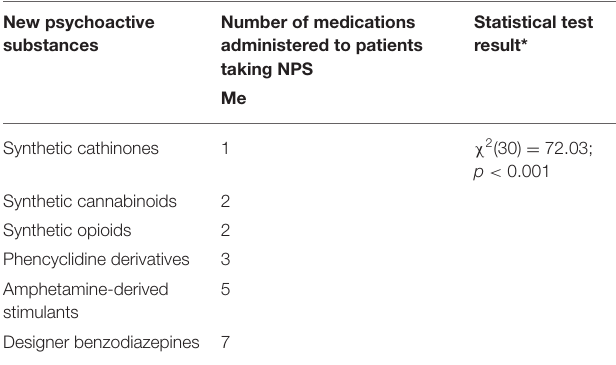
TABLE 4 | Number of medications administered to patients taking various types of NPS; Me - median; *chi-square. New psychoactive